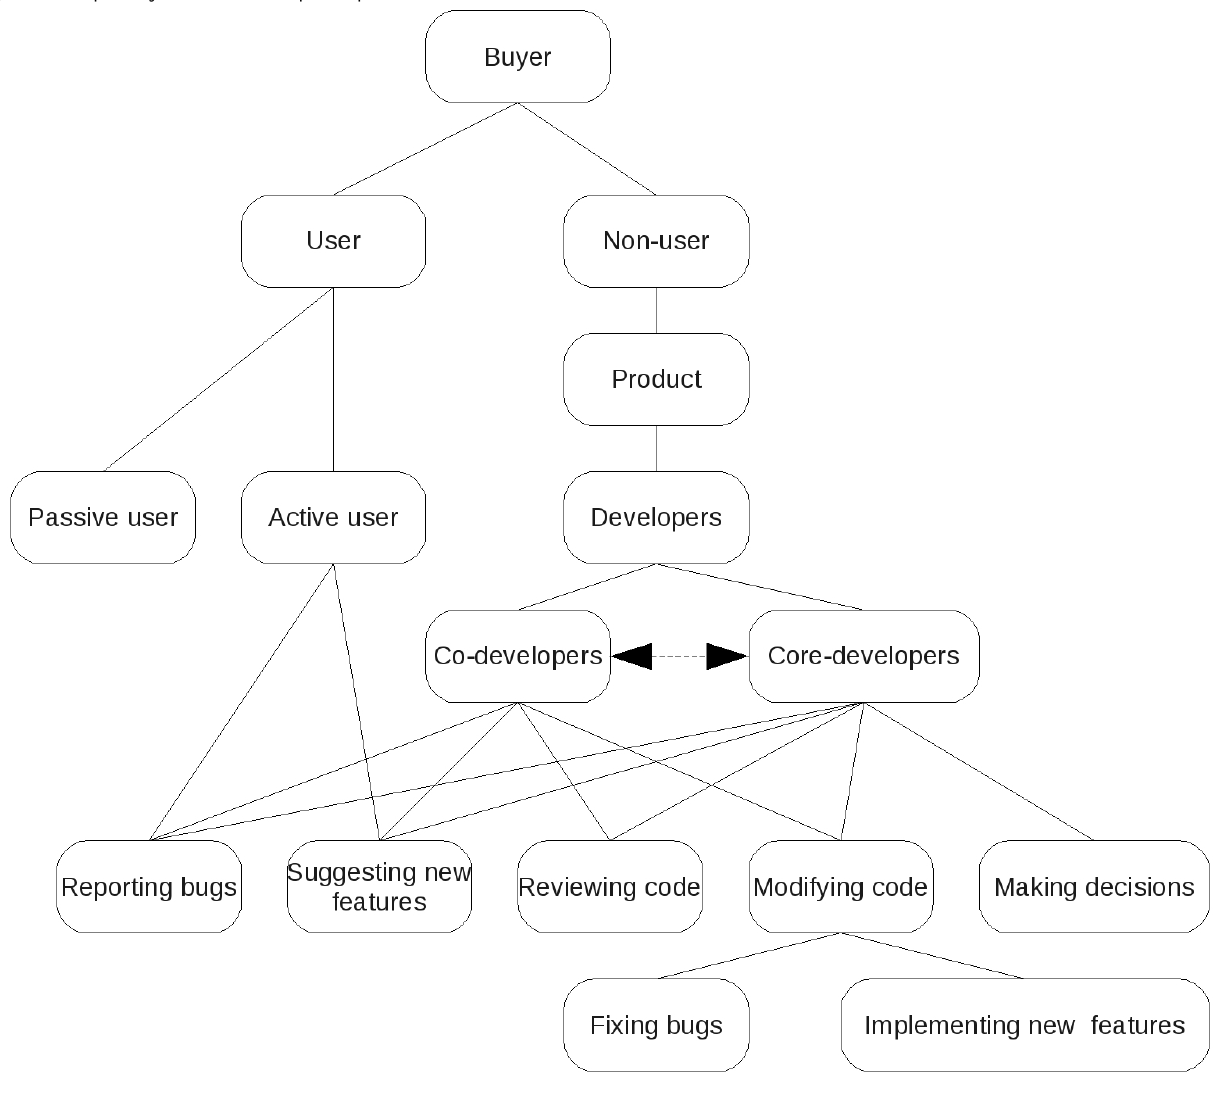
Figure 3. Proprietary software development process